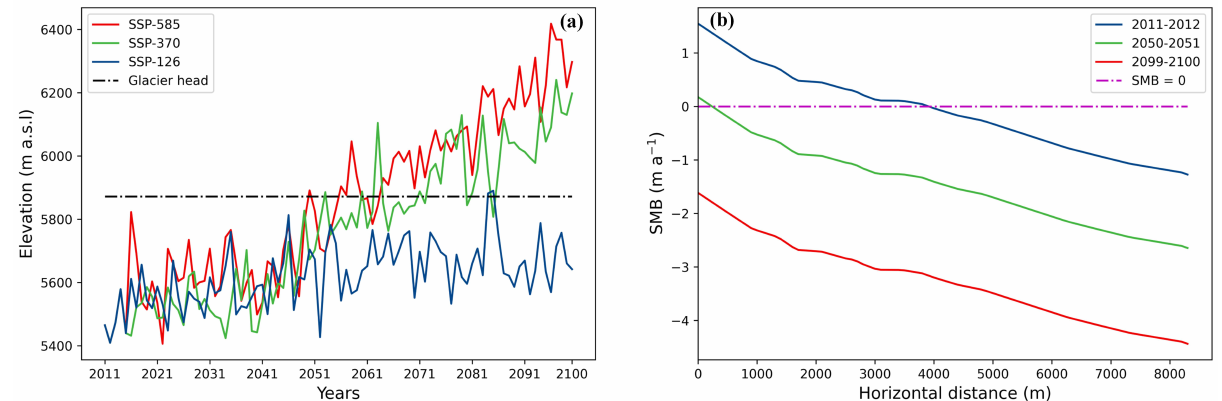
Figure 6. The SMB parameterization for JMYZG. ( a ) Time series of the ELA changes under different climate scenarios; the black dash-dotted line represents the elevation of the glacier head; ( b ) SMB parameterization under SSP5-8.5; the magenta dash-dotted line represents where the SMB is 0 m a − 1